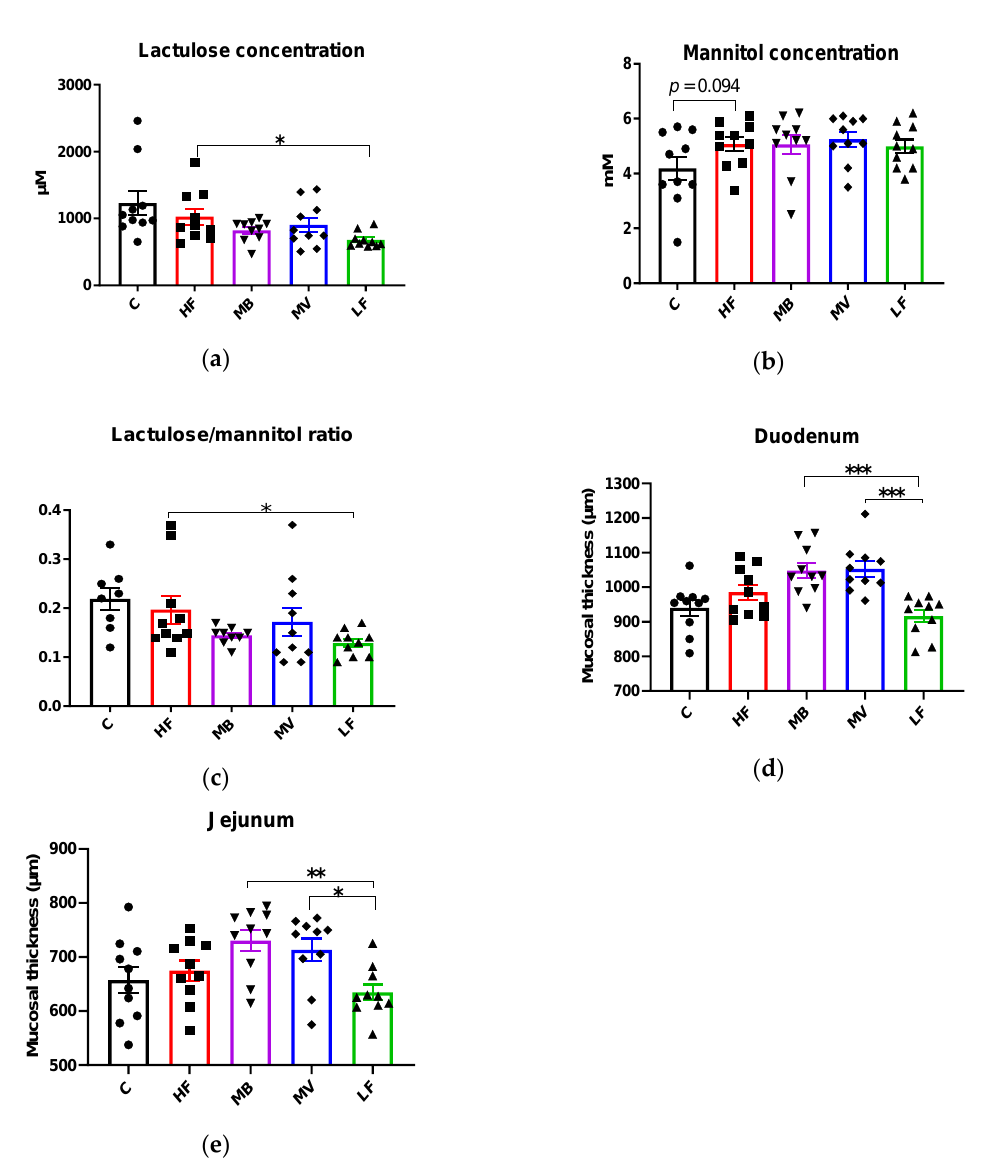
Figure 1. Changes in ( a ) lactulose (µM), ( b ) mannitol (mM), and ( c ) lactulose/mannitol in urine, and mucosal thickness (µm) in the ( d ) duodenum and ( e ) jejunum of conventional rats fed a pure high-fat diet (C), or Apolipoprotein E-knockout (ApoE-/-) rats fed a low-fat diet (LF) or high-fat diet (HF), pure or supplemented with 1% monobutyrin (MB) or monovalerin (MV) for 5 weeks ( n = 10 / group). Rats from the C, HF, MB, MV and LF groups are shown as • , (cid:4) , (cid:72) , (cid:7) and (cid:78) , respectively. Values are means ± SEM. * p < 0.05, ** p < 0.01.